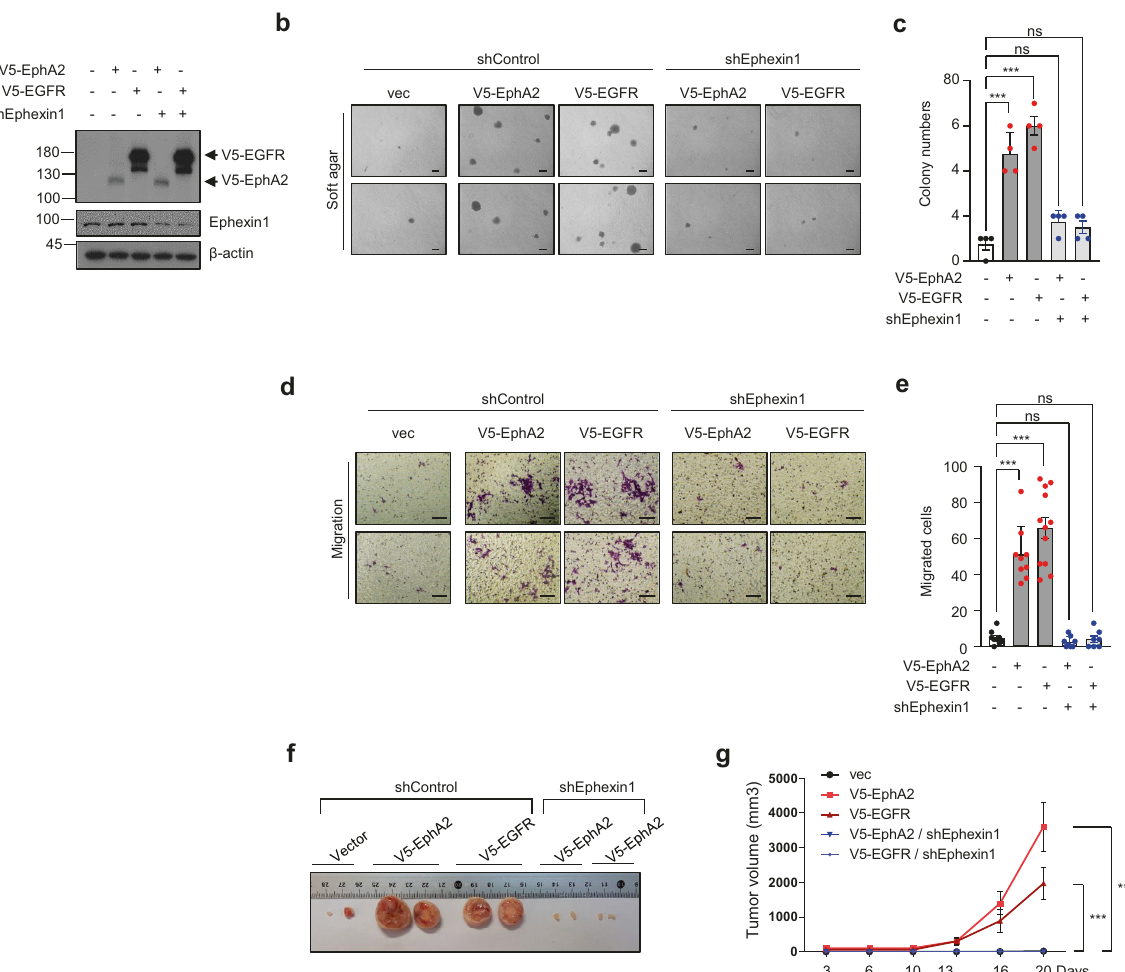
Fig. 5 In the absence of Ephexin1, the tumorigenesis normally induced when EphA2 or EGFR is overexpressed is decreased. a Western blot analysis using the indicated antibodies of extracts from HEK293T cells stably transfected with V5-tagged EphA2 or V5-tagged EGFR, with or without the shEphexin1 plasmid. b Anchorage-independent growth assay of cells with V5-tagged EphA2 or V5-tagged EGFR, with or without the shEphexin1 plasmid. Representative images are shown. Scale bar = 100 μ m. c Quanti fi cation of the anchorage-independent growth assay shown in ( b ). p values are for a two-tailed Student ’ s t test, *** P < 0.001. ns, not signi fi cant. d Migration assay of cells with V5- tagged EphA2 or V5-tagged EGFR, with or without the shEphexin1 plasmid. Representative images are shown. Scale bar = 100 μ